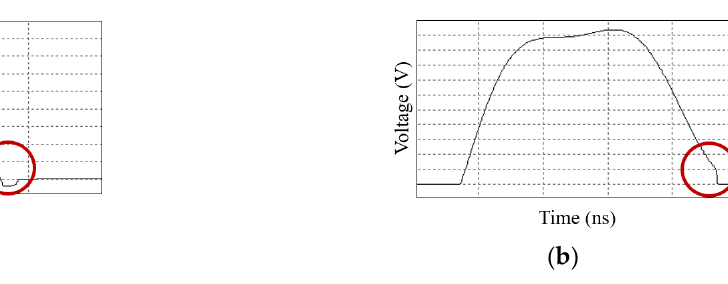
Figure 2. Drain − source voltage waveform in ( a ) quasi − ZVS and in ( b ) hard switching.